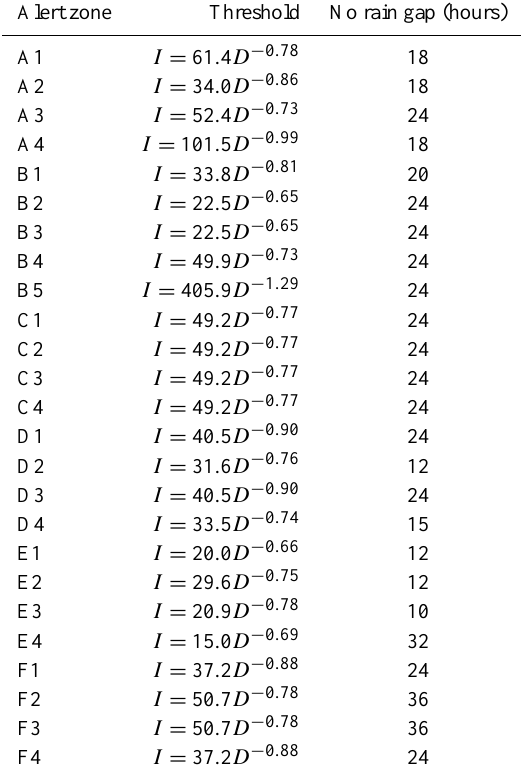
Table 1. Threshold equation and no rain gap values used in the early warning system for each alert zone (modified after Segoni et al., 2014b).